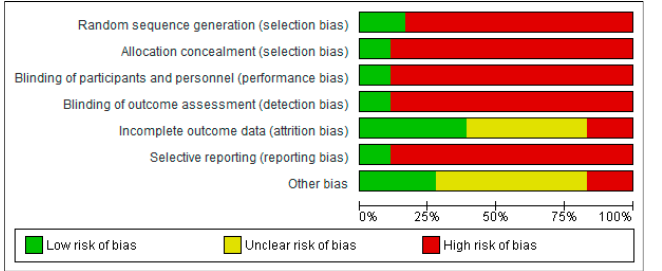
Figure 3. Risk of bias graph representing author’s judgement about each risk of bias item presented as percentage of risk across all studies.